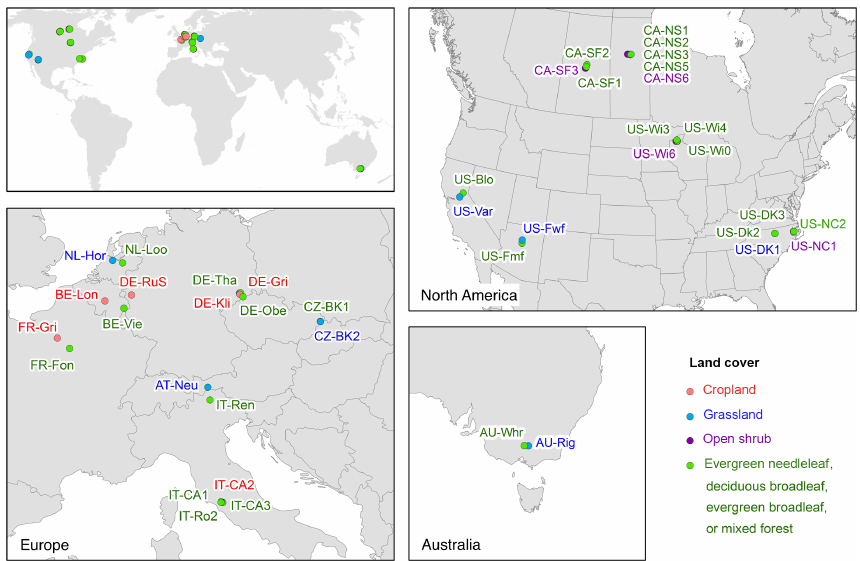
Figure 1. Location and land-cover type of the paired sites. The land-cover type of each site is based on the reported land cover in FLUXNET